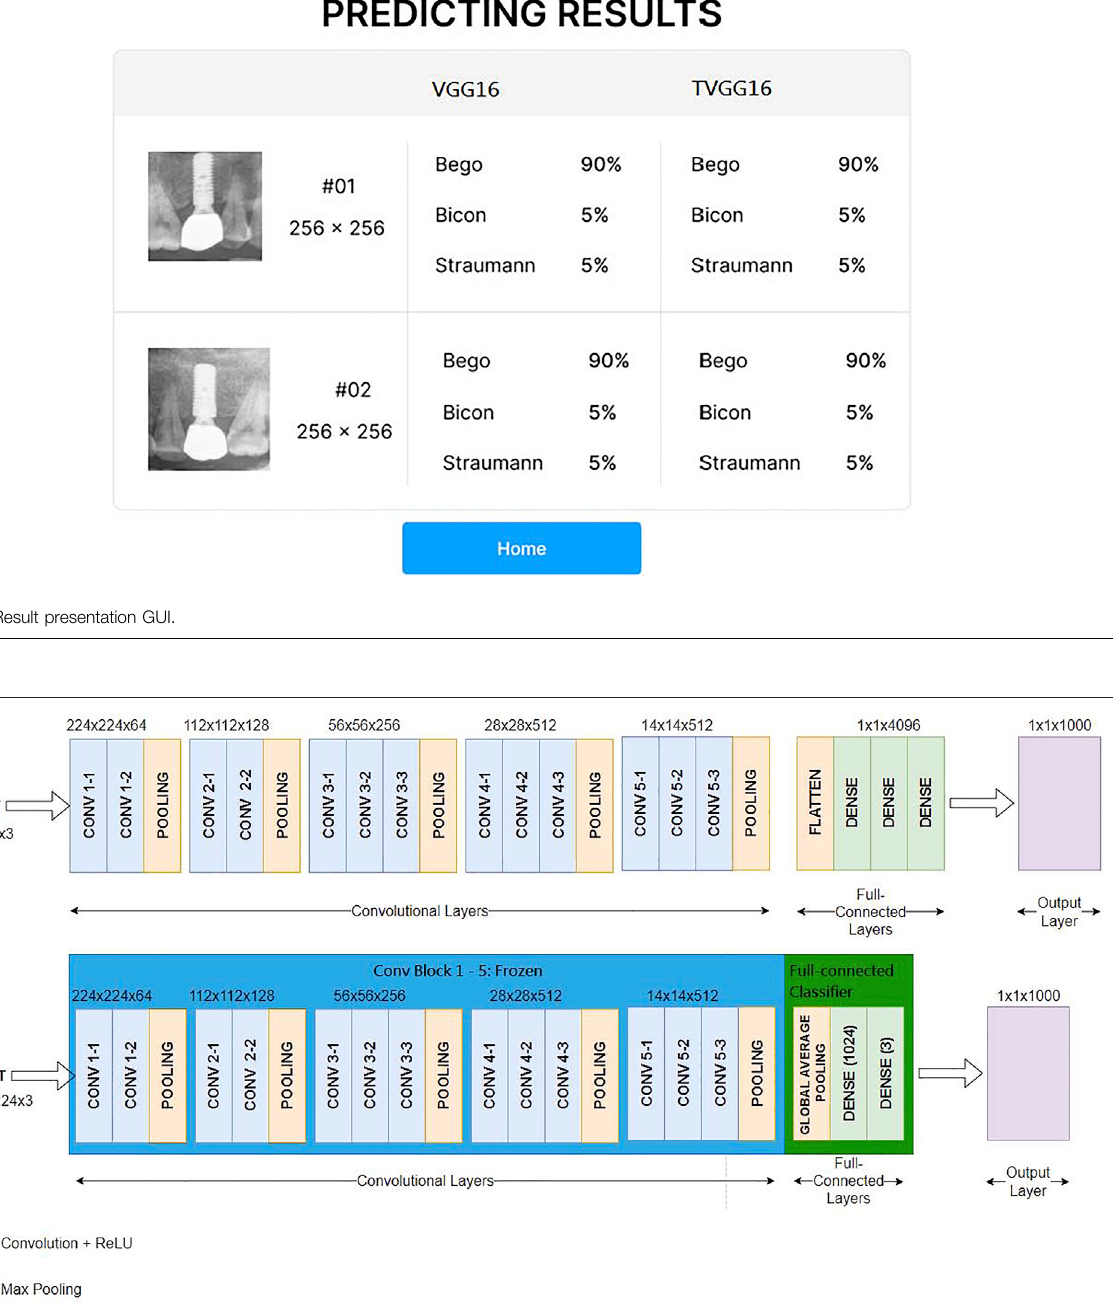
Frontiers in Pharmacology |